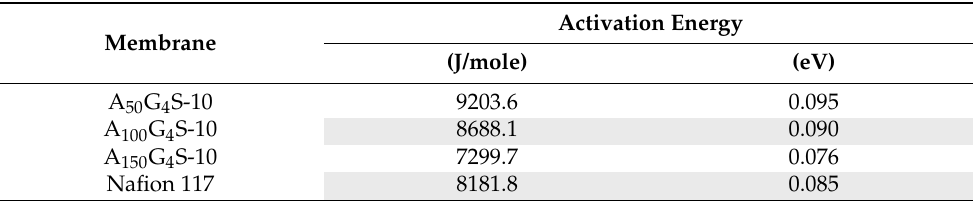
Table 3. Activation energies of cross-linked diblock ionomer membranes. A Nafion 117 membrane is included for comparison.